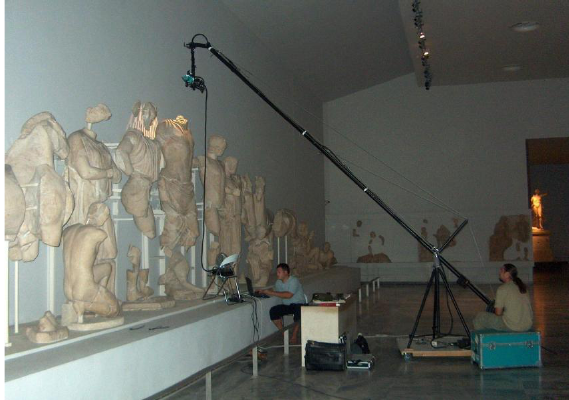
Figure 5. The scanner mounted on the Jimmy Jib in the Archaeological Museum of Olympia. Photo: author.